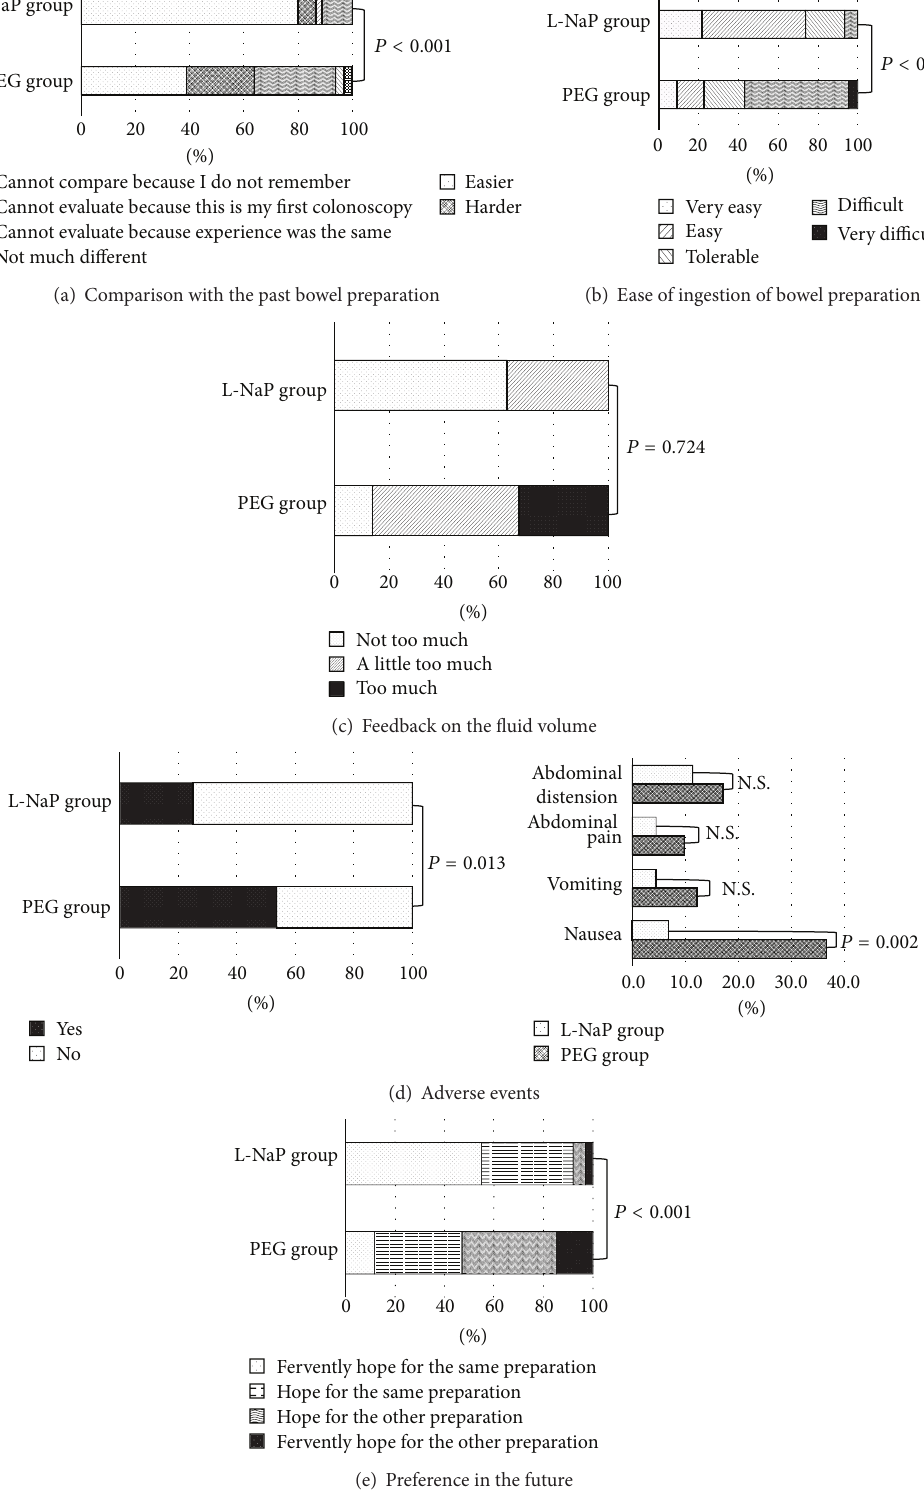
Figure 3: Outcomes of assessments of acceptability, tolerability, and